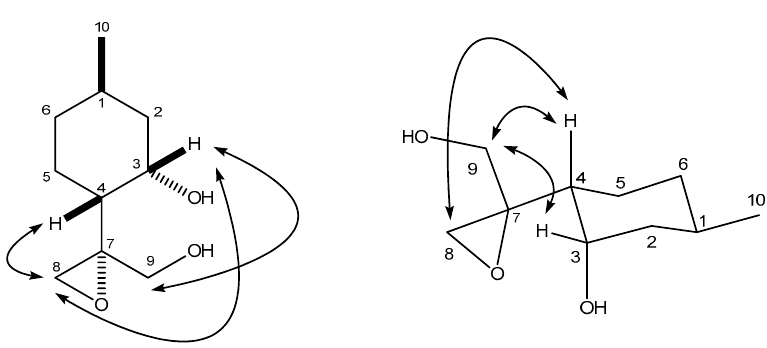
Figure 4. Determination of the structure of epoxide 31 by NOESY.